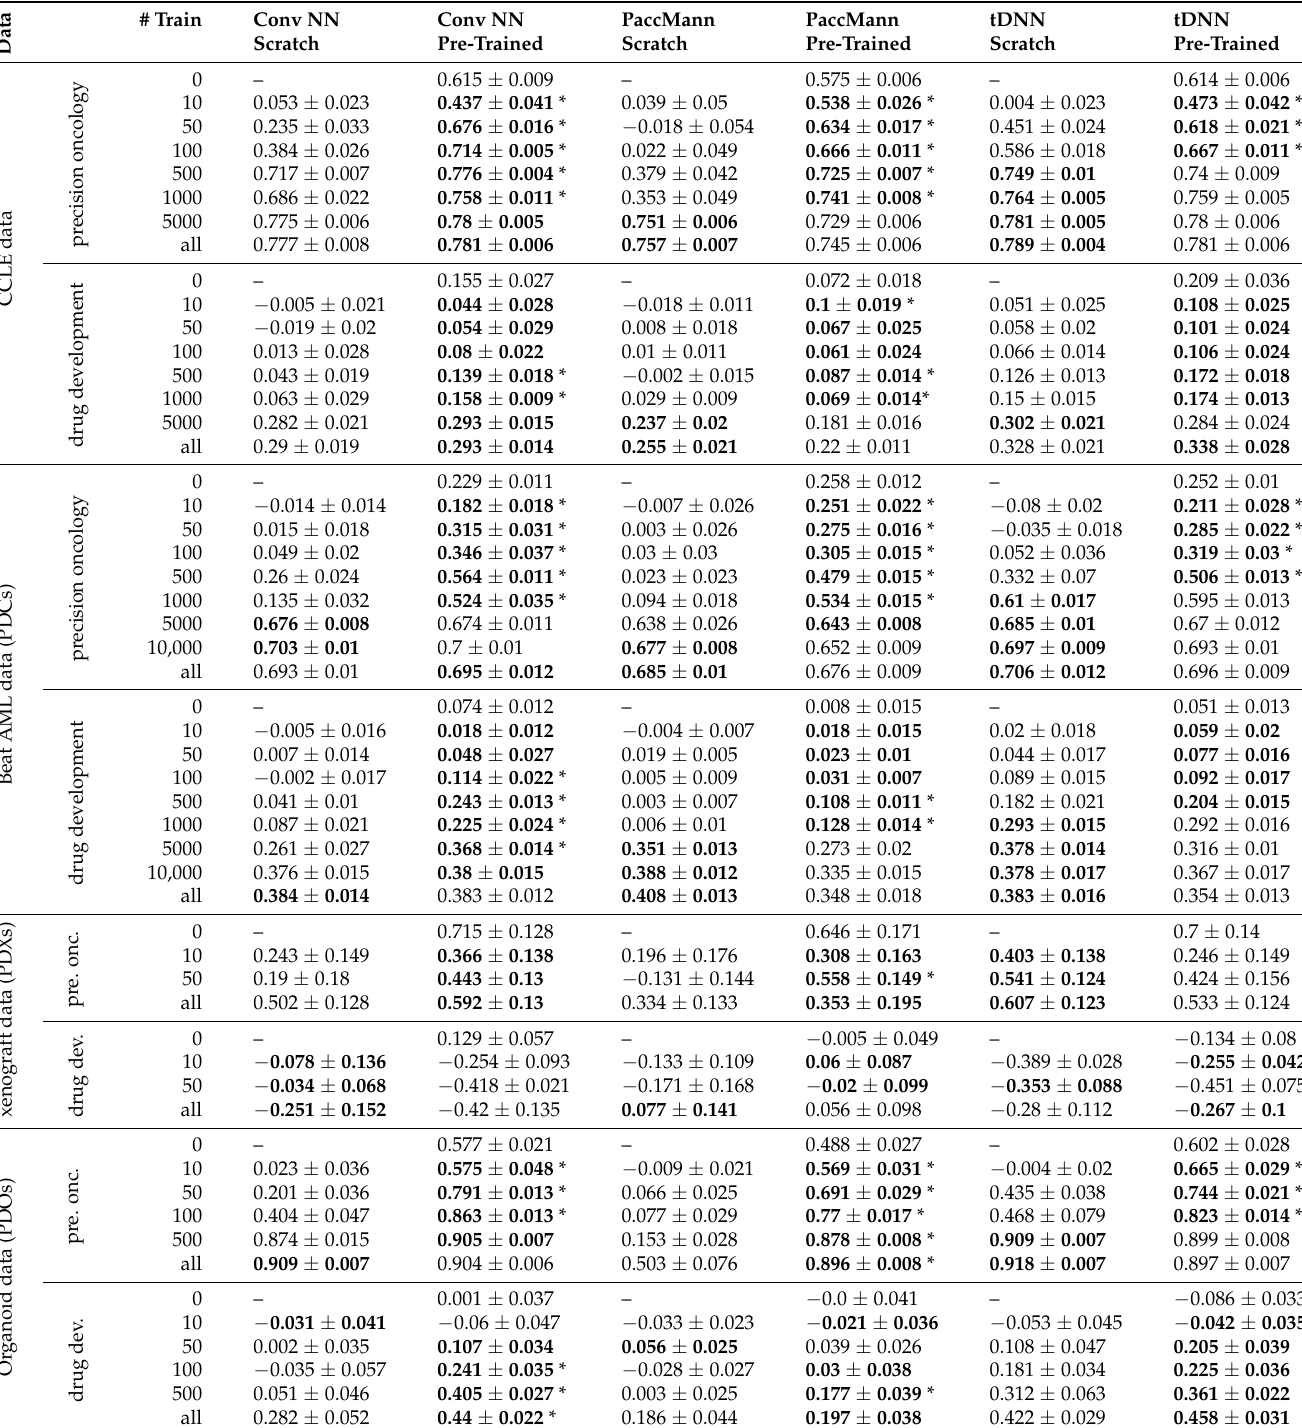
Table 2. Average Pearson correlations for different models and the different data sets. For results marked “*”—the correlation of the pre-trained model is significantly higher ( p < 0.05) than that of the same model trained from scratch. Results highlighted in bold mark the best performing model regarding the model trained from scratch and its pre-trained